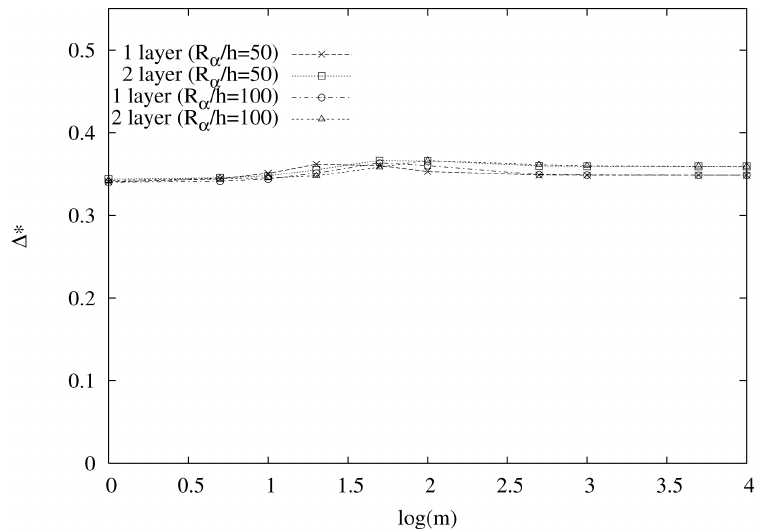
(cid:28) (cid:29) 2 2 ( f ) calculated by using i TMi − f i f 2 i